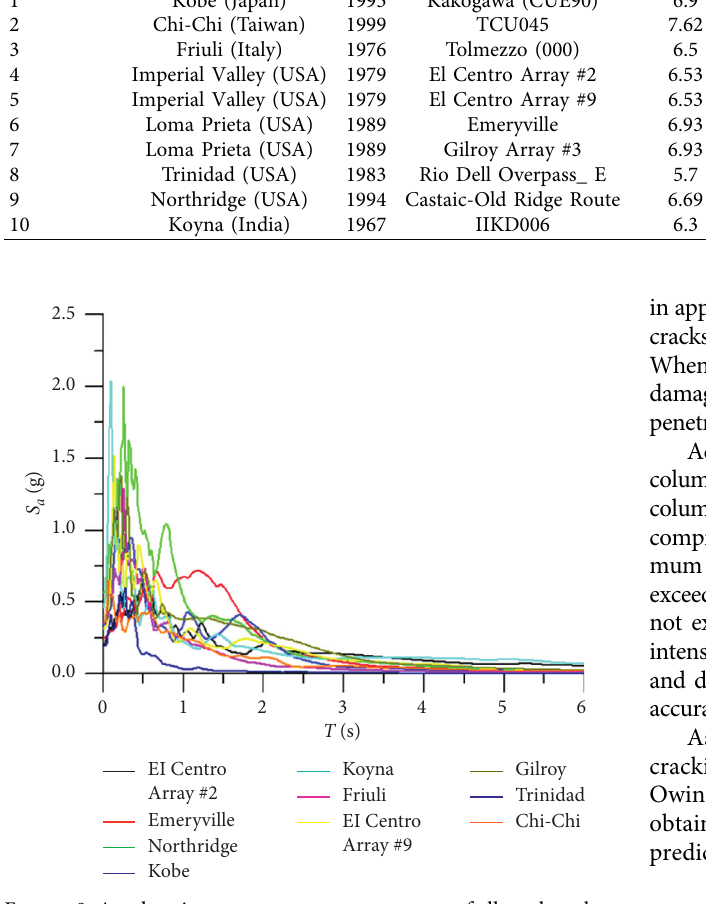
Figure 9: Acceleration response spectrum curves of all earthquake records used in the